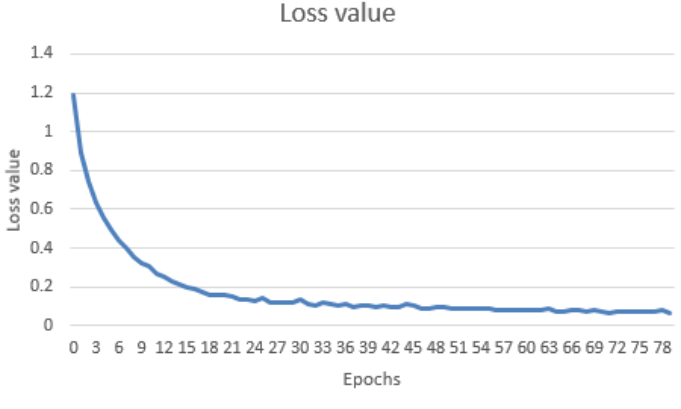
Figure 9. Loss of training BiseNet on the Potsdam dataset.